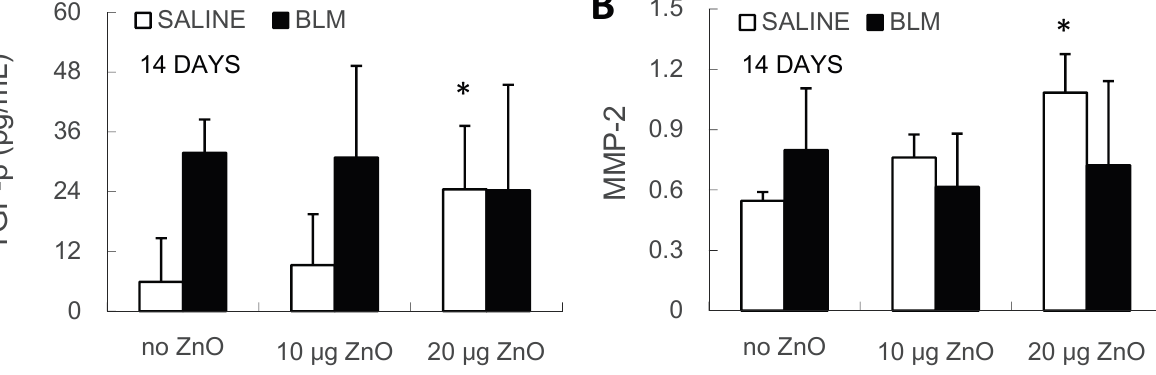
Figure 6. ( A ) TGF- β level in BALF and ( B ) MMP-2 relative mRNA expression level in lung tissue were determined at Day 14 after administration. Mice were exposed to ZnO nanoparticles with or without BLM treatment. The number of mice was six in the SALINE-no ZnO, seven in the SALINE-10 µg of ZnO, six in the SALINE-20 µg of ZnO, six in the BLM-no ZnO, six in the BLM-10 µg of ZnO and seven in the BLM-20 µg of ZnO group. Data are the means ± SD; * p < 0.05; compared to the vehicle